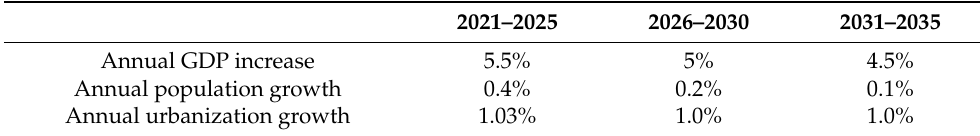
Table 3. Prediction of socio-economic